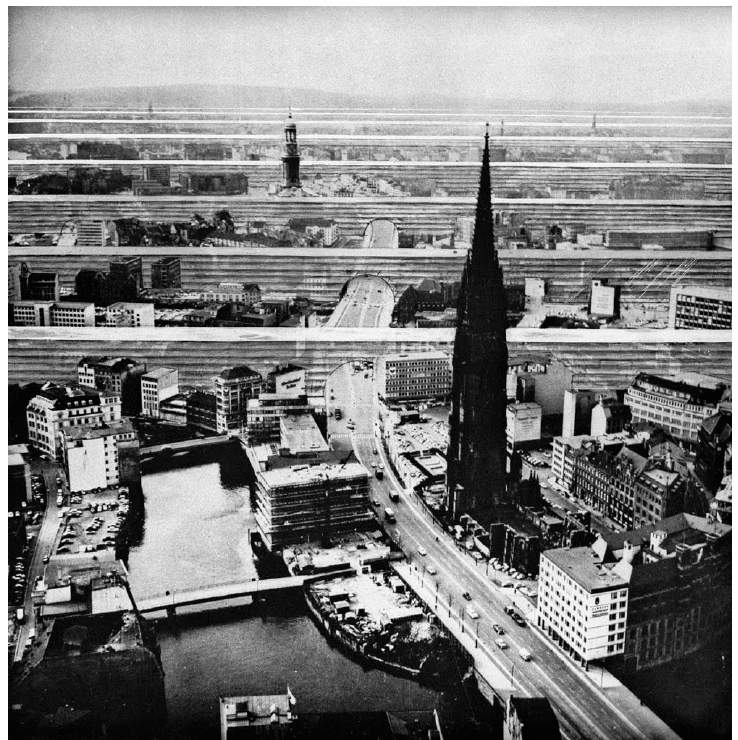
Figure 5. No ‐ Stop City. (Veduta di città ʹ ) 1970 by the radical Italian architects Archizoom, Religious Figure 5. No-Stop City. (Veduta di città') 1970 by the radical Italian architects Archizoom, Religious high ‐ rise elements for boasting power among borders of regions. high-rise elements for boasting power among borders of